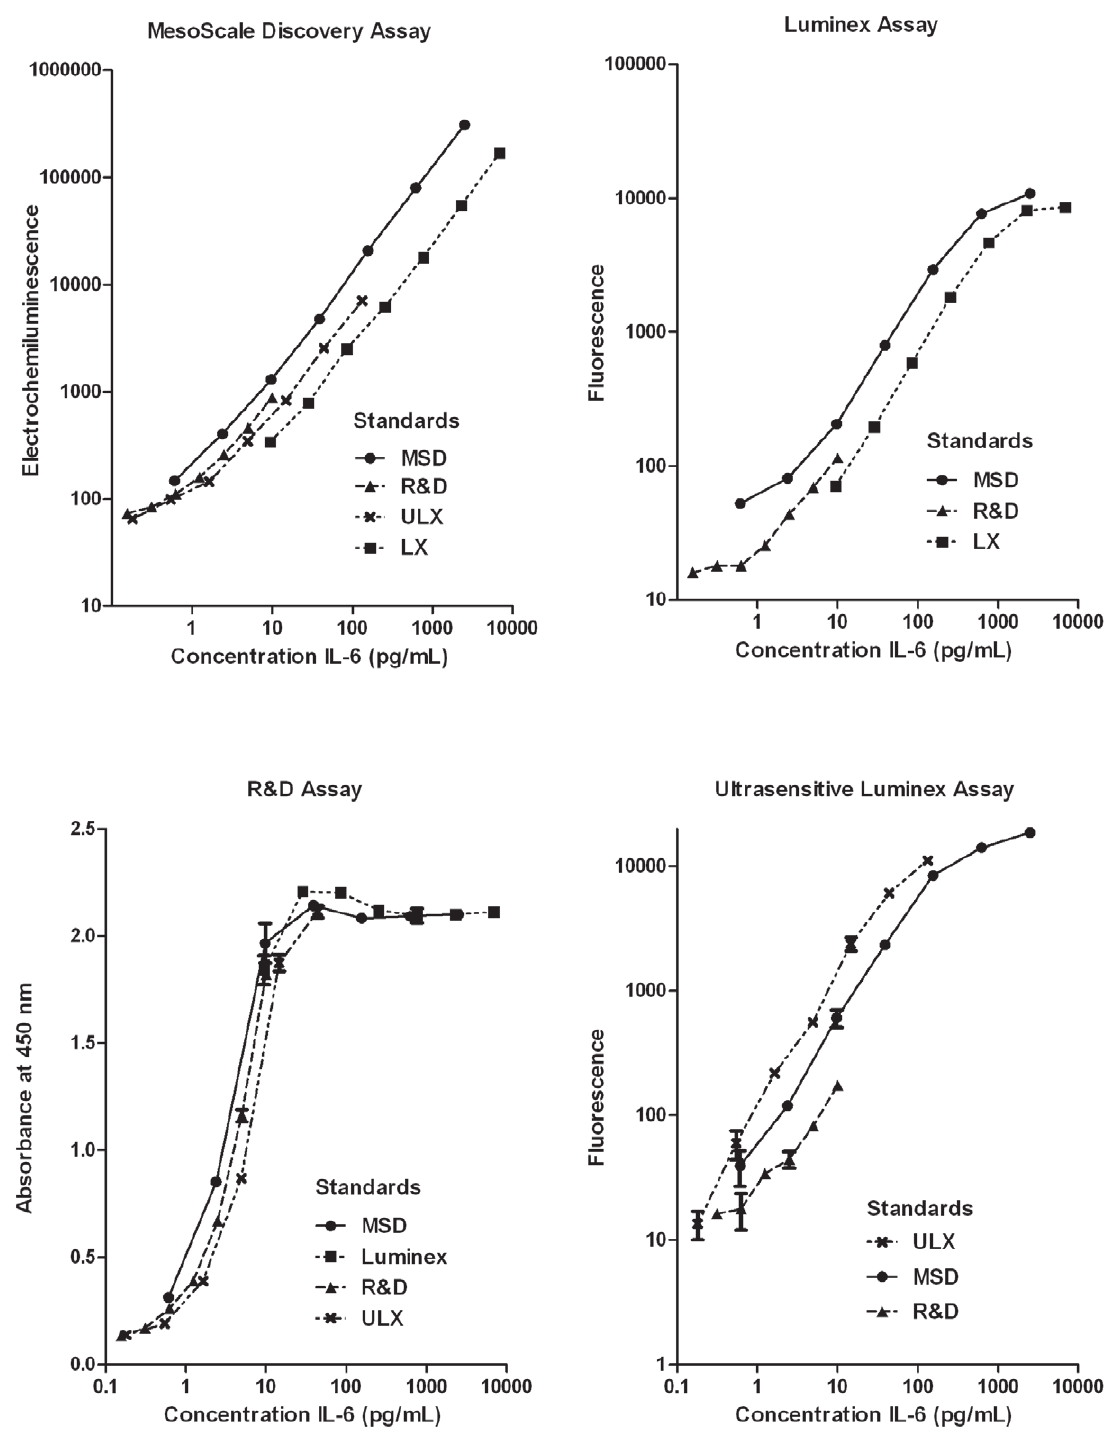
Figure 1. IL-6 protein calibrators of four immunoassays. IL-6 calibrators (standards) from MesoScale Discovery ( N MSD), Invitrogen Luminex ( & LX), and R&D High Sensitivity ELISA ( m R&D), and Invitrogen Ultrasensitive Luminex ( 6 ULX) were assayed using each of four manufacturers’ kit components. Values represent duplicate measurement for MSD and R&D, and duplicate measures of at least 100 beads each for Luminex and Ultrasensitive Luminex. doi:10.1371/journal.pone.0030659.g001 deviations from the mean. Bland Altman plots revealed the highest assessing agreement between assays, the hundreds-fold higher agreement (narrower limits of agreement) between MSD, R&D, values returned by LX compared with the other three assays and ULX, and essentially no agreement between LX and any of necessitated comparison across assays using z scores that the other assays (Figure 2). normalize each set of values and express them as standard